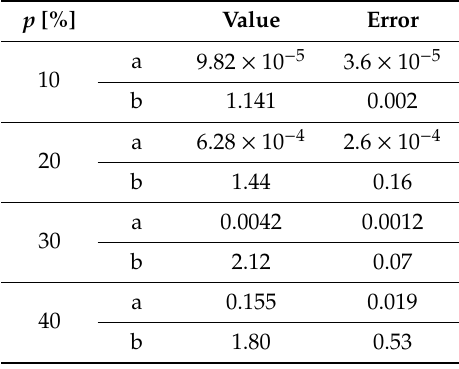
Table 1. Linear regression results of relative sheet resistance as a function of l / w stripe ratio (cid:19) (cid:18) R s ≈ a l + b w R s min